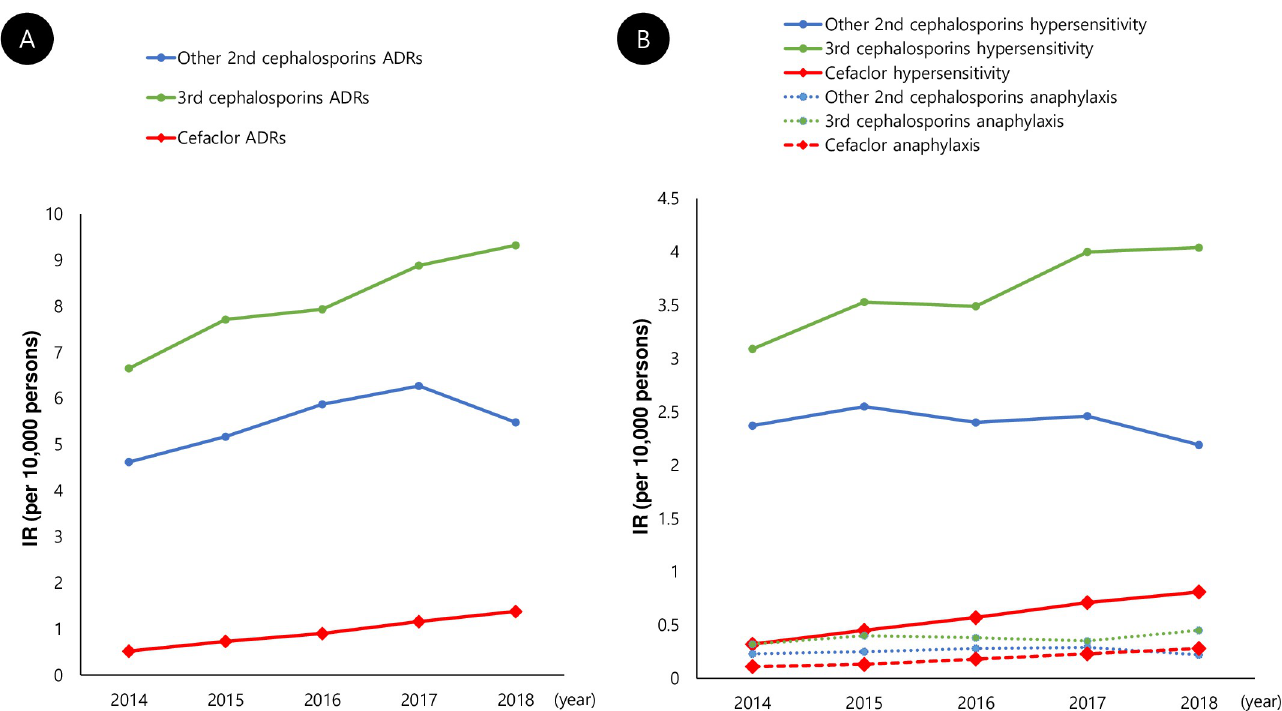
Fig 1. Annual incidence rates of adverse drug reactions, hypersensitivity, and anaphylaxis to cefaclor and other 2 nd and 3 rd cephalosporins during the study period. ADR: Adverse drug reaction.